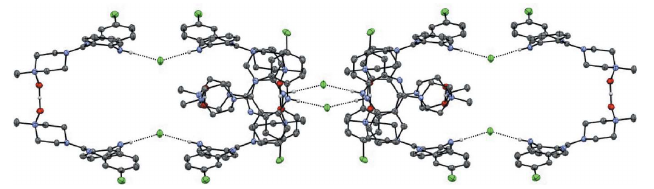
Figure 4 Partial structure of (CNO) 2 (cid:2) HCl catenated chain showing three members of the poly[ n ]catenane; adjacent links in the chain are related by a 4 2 screw axis.